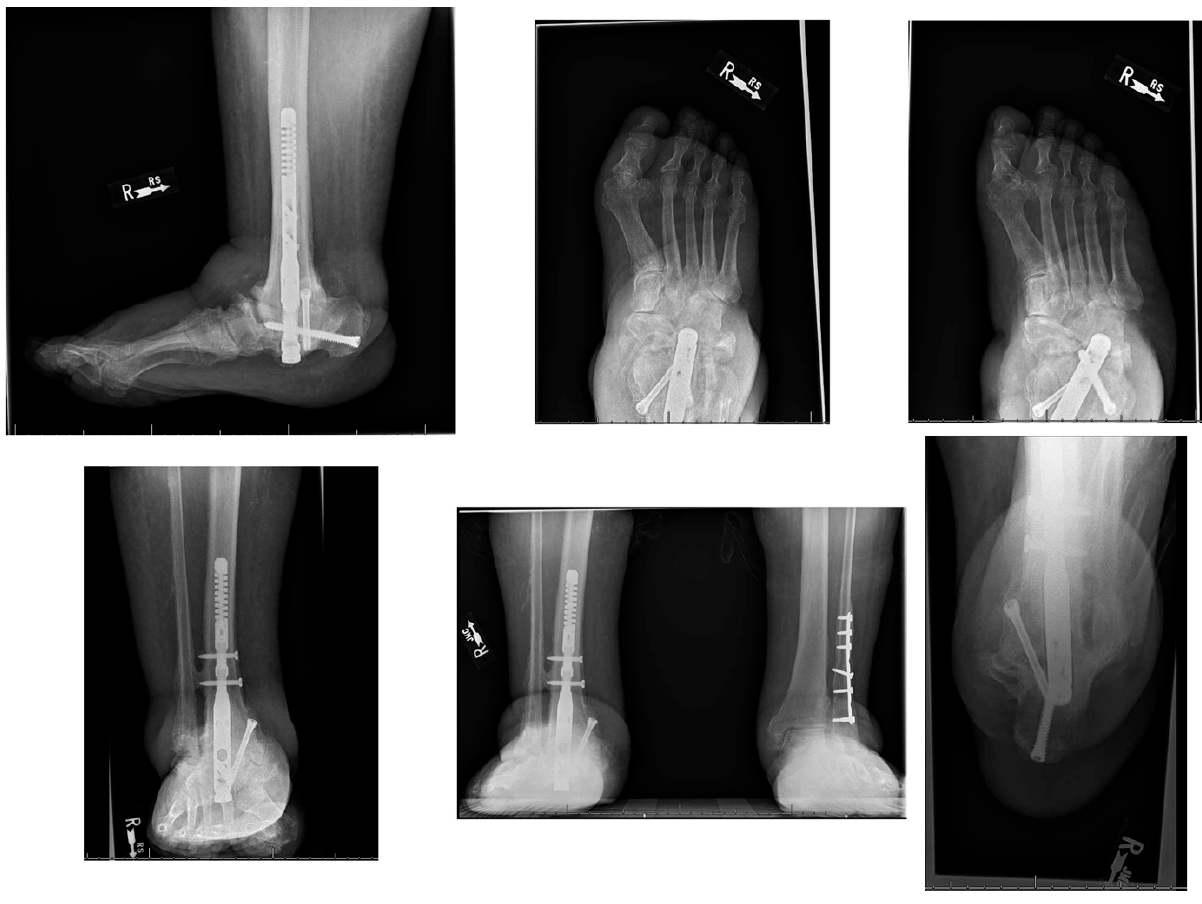
Figure 10. The final one-year postoperative weightbearing